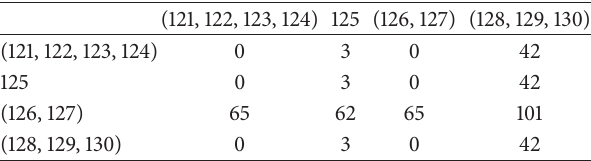
Table 6: The distance matrix in second stage.